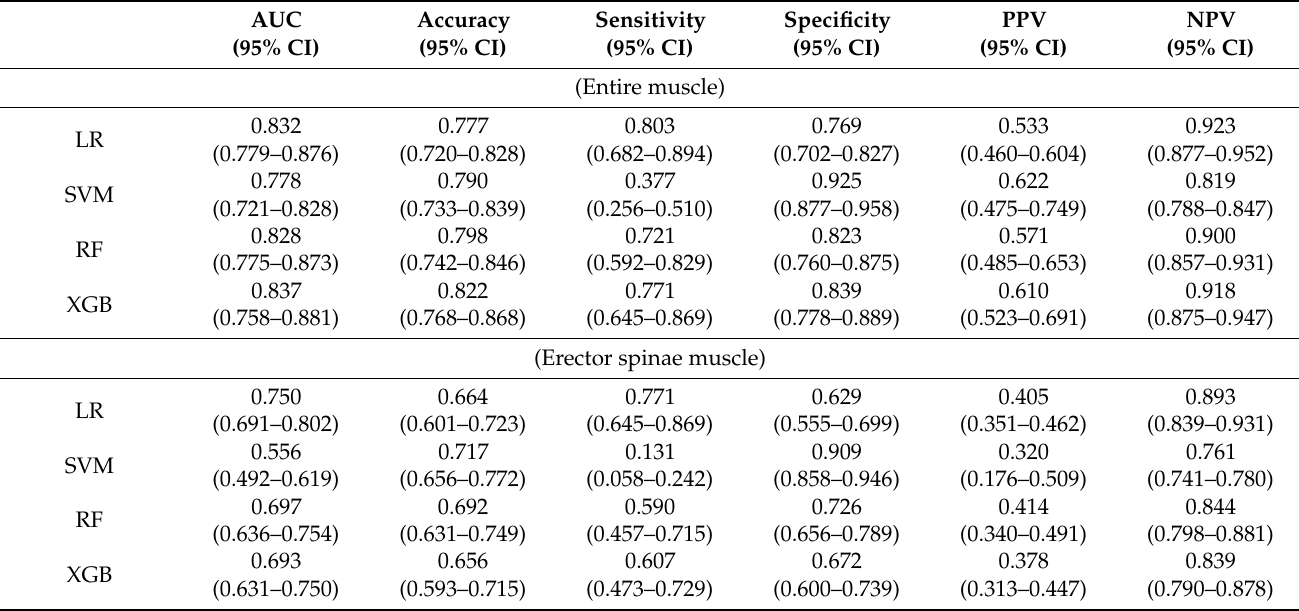
Table 3. AUC, sensitivity, specificity, PPV, and NPV of each machine learning model for the identification of sarcopenia in the entire muscle and the erector spinae